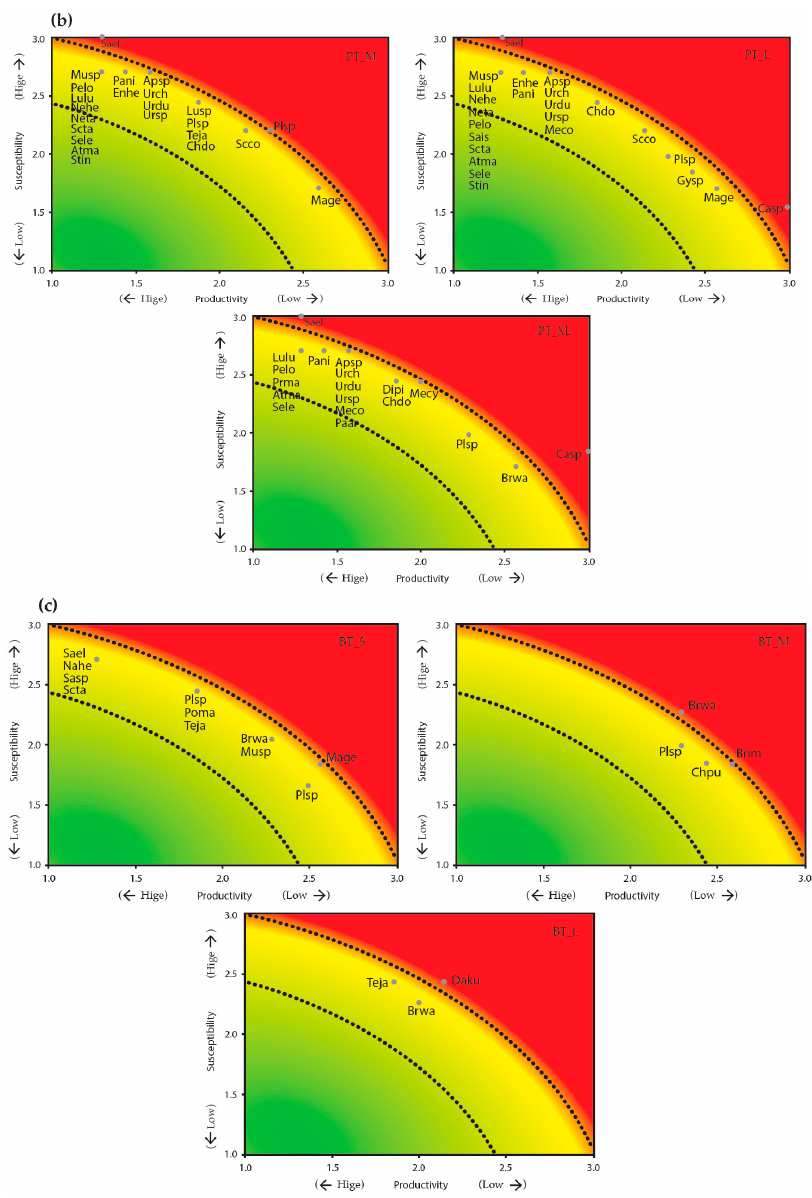
Figure 3. Productivity-susceptibility plots of high and high-medium vulnerability taxa in landings of trawl fi sheries in the Gulf of Thailand by trawl type and vessel size. Trawl type: ( a ) OBT = O tt er- board trawl, ( b ) PT = Pair trawl and ( c ) BT = Beam trawl. Vessel size: SS (<10 gross tonnage, GT), S (10–29.9 GT), M (30–59.9 GT), L (60–149.9 GT) and XL (>150 GT). The curved do tt ed lines represent boundaries for low vulnerability (V score < 2.64), moderate vulnerability (V score 2.64 ≤ V ≤ 3.18) and high vulnerability (V score > 3.18). Note Brwa: Brevitrygon heterura , Sael: Saurida elongata , Plsp: Plotosus spp., Mecy: Megalops cyprinoides , Apsp: Apogon spp, Gysp: Gymnothorax spp., Musp: Mugil spp., Trle: Trichiurus lepturus , Plin: Platycephalus indicus , Sais: Saurida isarankurai , Gami: Gazza minuta ,